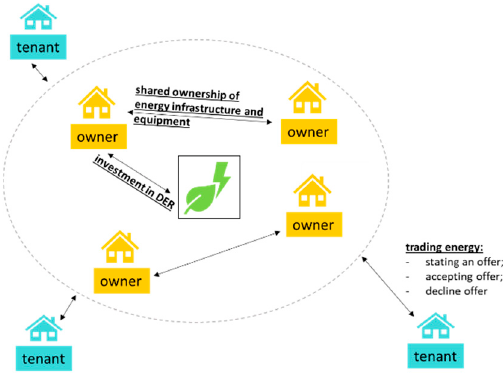
Figure 8. Peer-to-peer energy market use-case. Dashed line denotes the community.